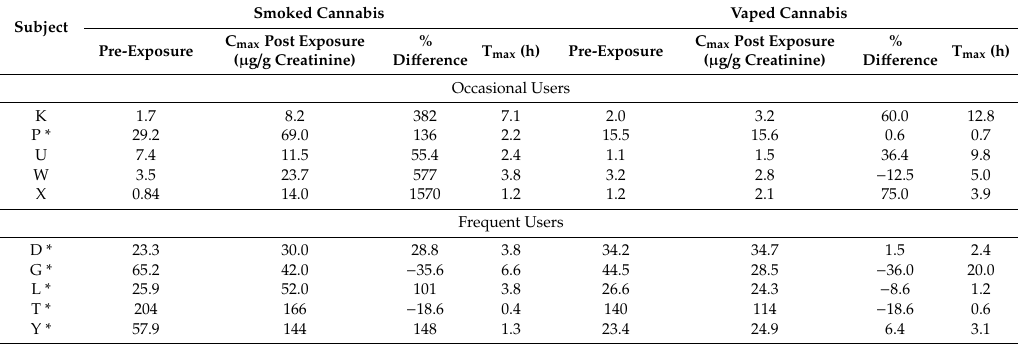
Table 1. Creatinine-corrected urinary 2CYEMA concentrations in occasional and frequent cannabis users immediately before product use, maximum concentrations (C max ), and time to maximum concentration (T max ) following product use.